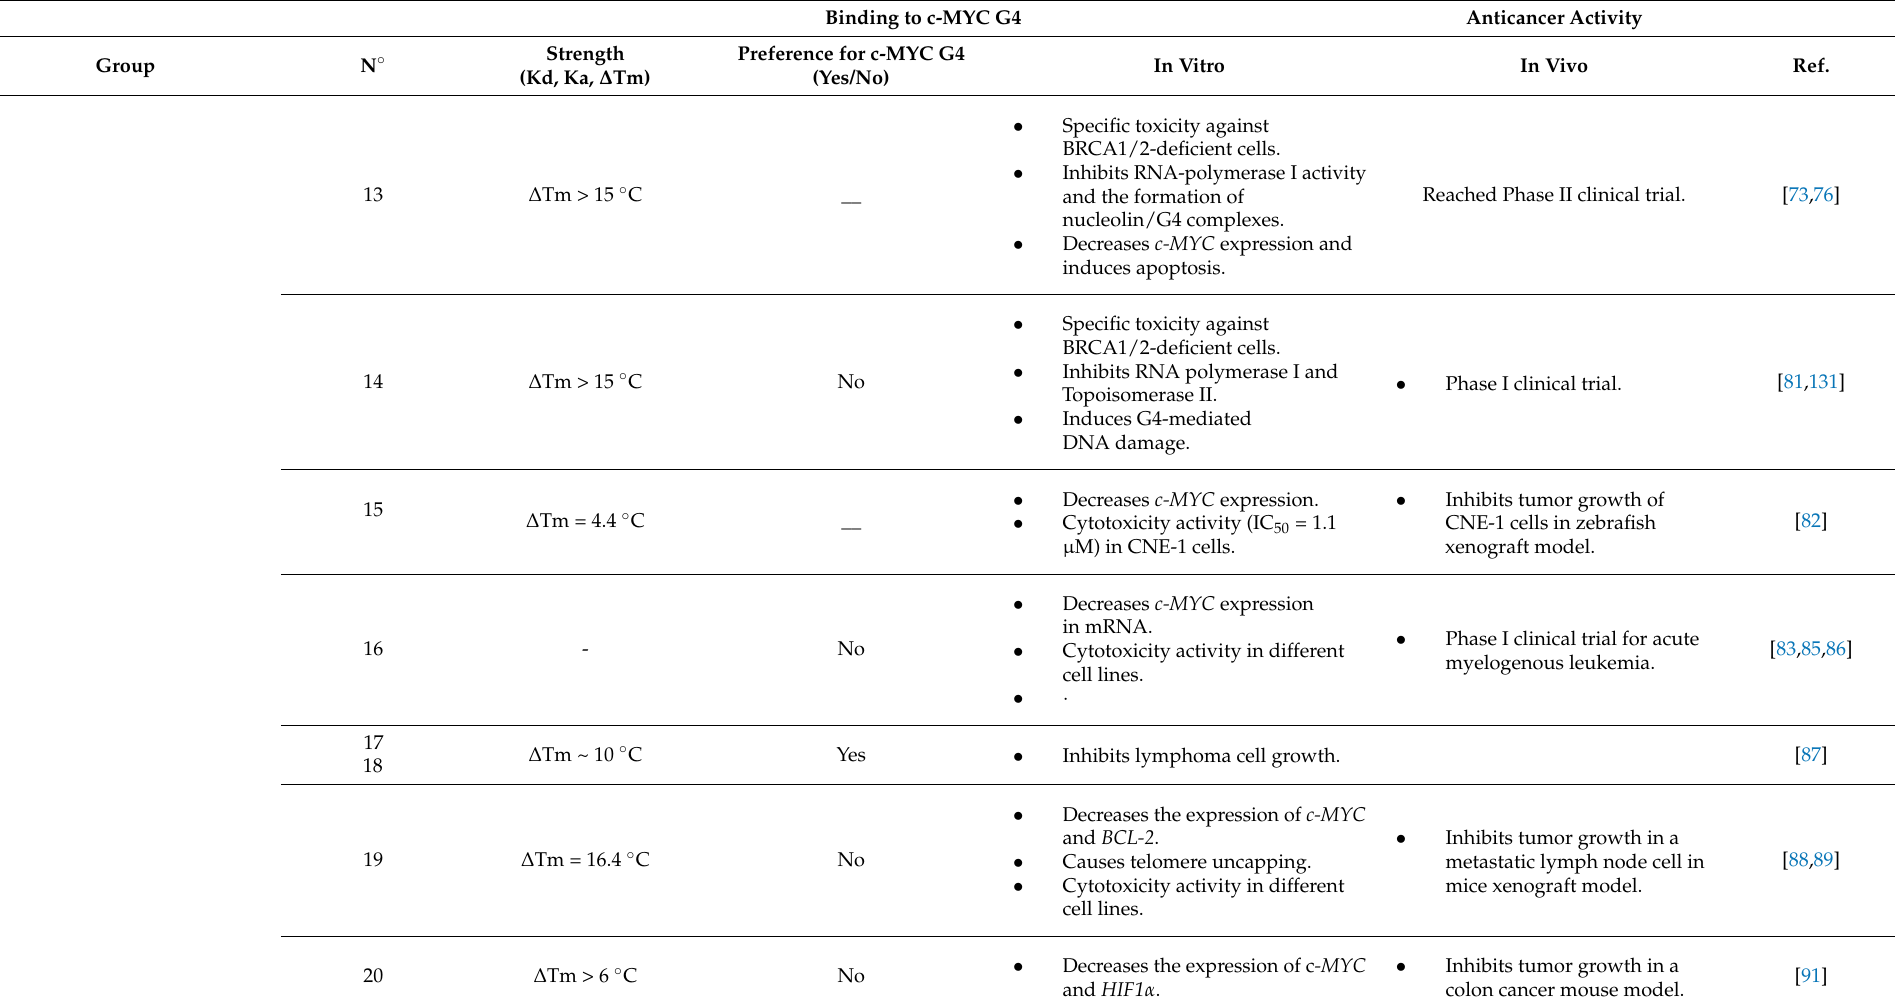
Table 1. Cont. Binding to c-MYC G4 Anticancer Activity Strength Preference for c-MYC G4 N ◦ (Kd, Ka, ∆ Tm) (Yes/No)